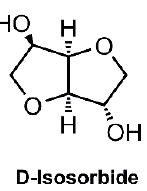
Figure 1. The molecular structure of D-isosorbide.